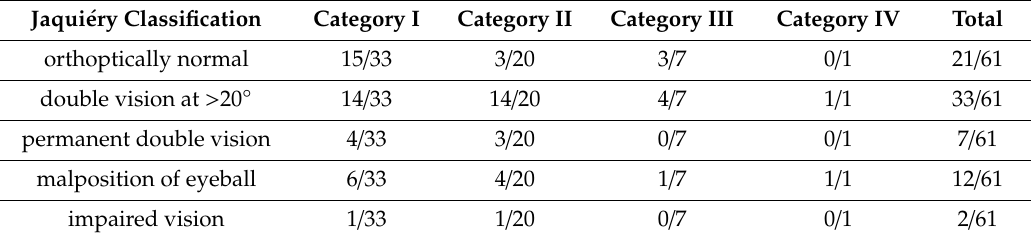
Table 1. Preoperative ophthalmologic and orthoptic assessment in 61 patients.